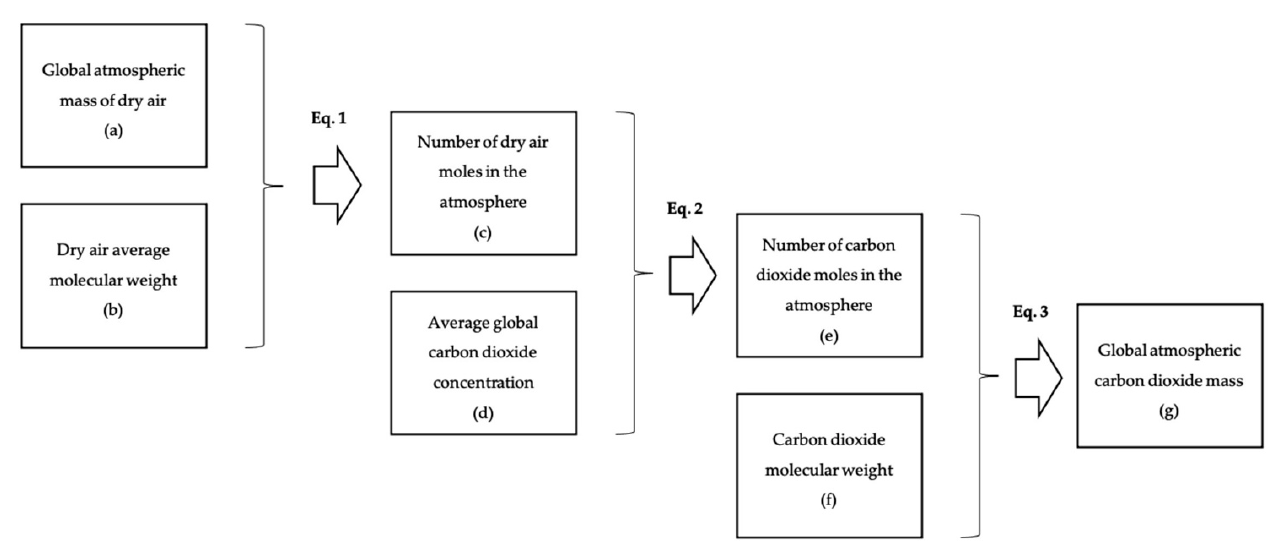
Figure 1. Building blocks for the global atmospheric carbon dioxide content calculation . Letters a-g are used to label the blocks in order to simplify mentioning the steps in the text.